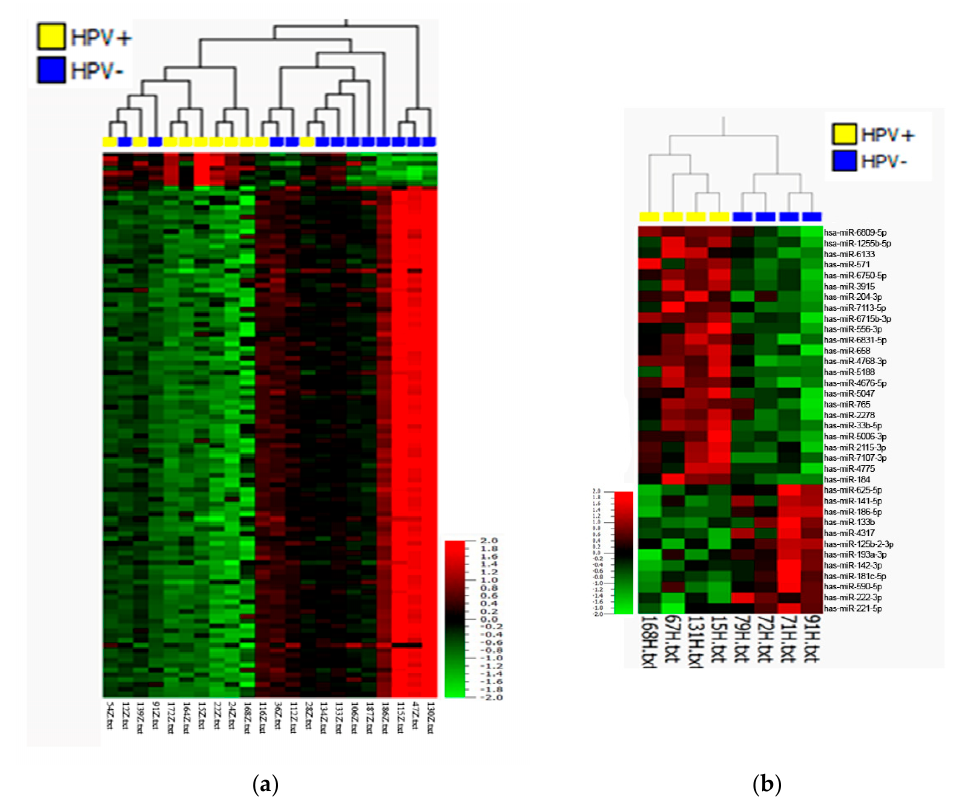
Figure 1. Heat map after unsupervised hierarchical clustering of differentially expressed miRNAs in HPV-positive versus HPV-negative ( a ) PSCC tumor tissues ( p ≤ 0.01; q ≤ 0.027; fold change ≥ 2) and ( b ) normal tissues ( p ≤ 0.05; q ≤ 0.37; fold change ≥ 2).